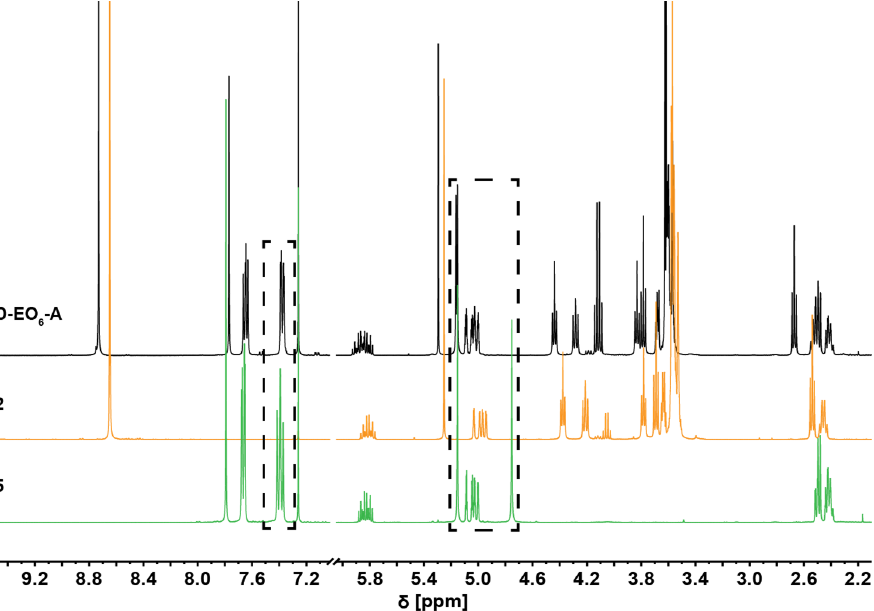
Figure 2. Comparison of the 1 H NMR spectra of D-EO 6 -A (black line), 2 (orange line), and 5 (green line). The comparison of the signals highlighted by the boxes indicates the successful formation of the covalently connected fluorophore–quencher pair. The splitting pattern of the aromatic region of 5 (around 7.3 ppm) and the down-field shift of the signals associated with the –CH 2 -OH methylene group after esterification (around 5 ppm) are diagnostic for the successful formation of D-EO 6 -A .